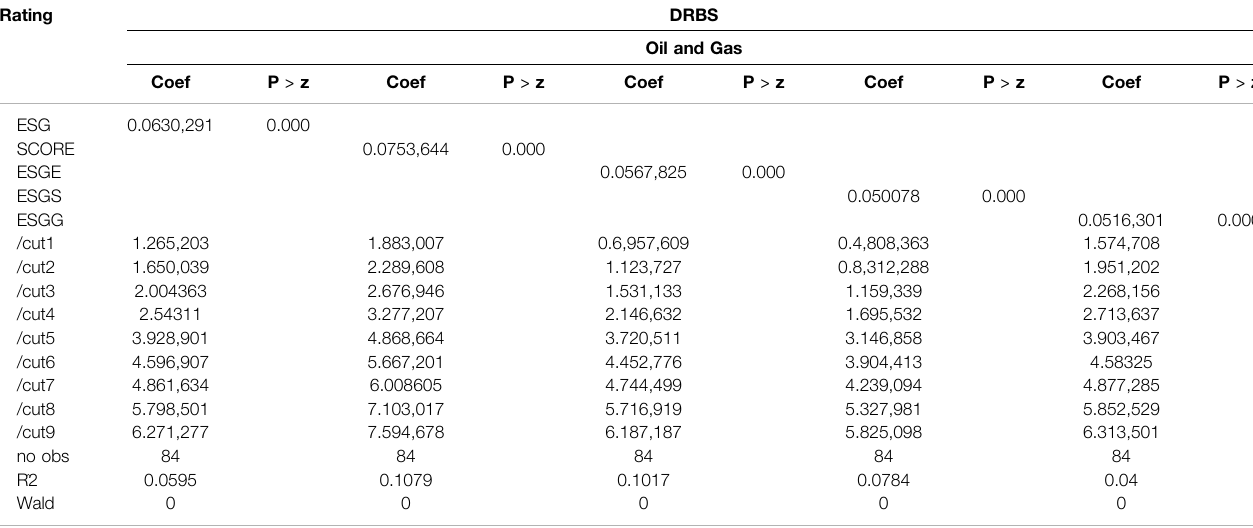
TABLE 11 | Impact of ESG factors on DRBS long-term issuer credit ratings according to sector division during the COVID-19 crisis. Rating